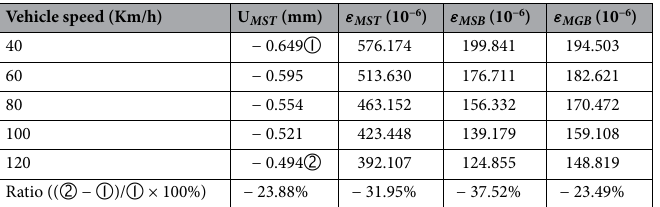
Table 4. Peak value of critical responses with different vehicle speed at the high temperature.